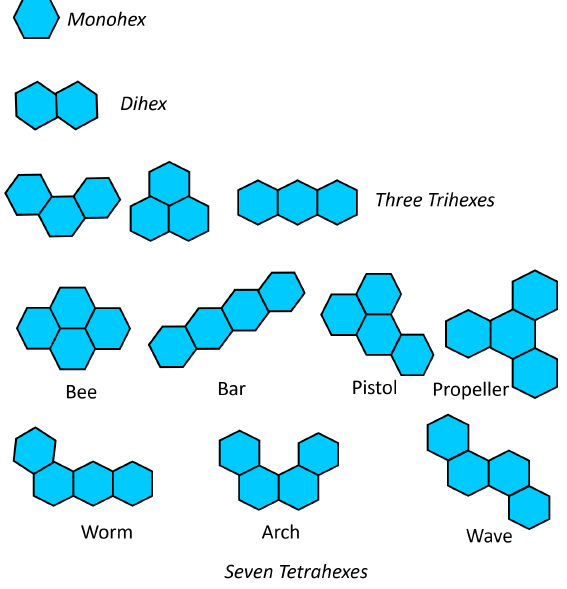
Figure 1. Schematics of various planar patterns of monohex, dihex, trihex, and